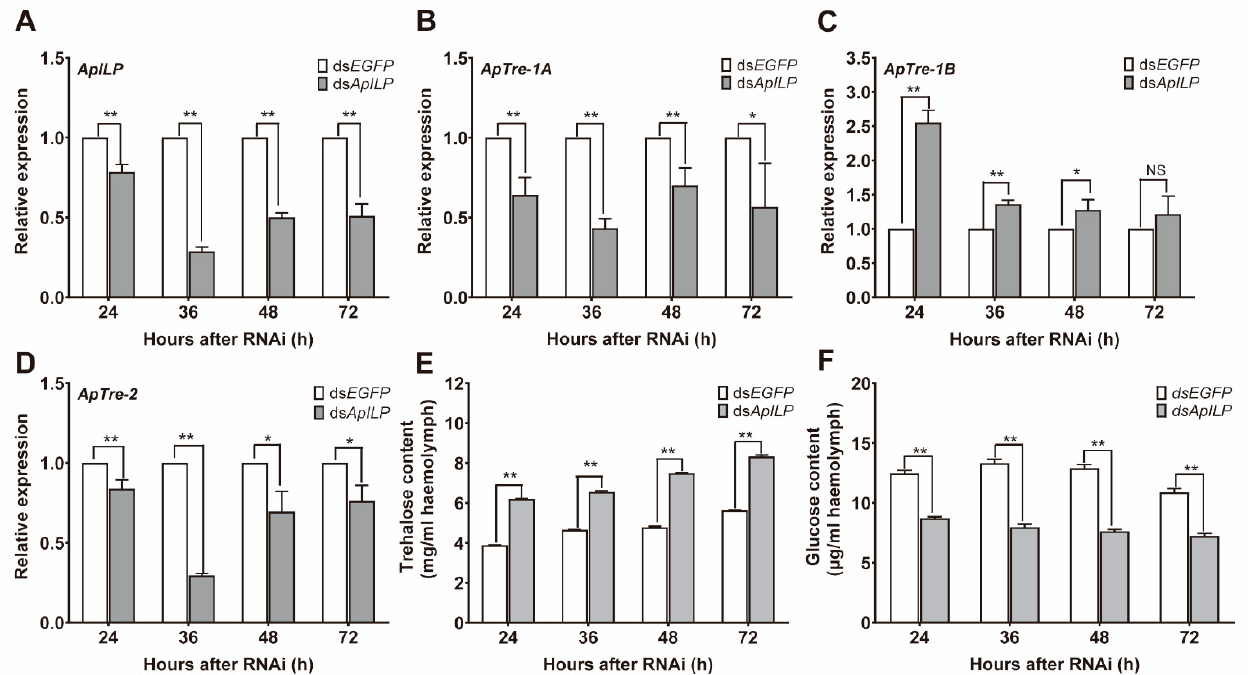
Figure 3. Effects of ApILP -specific RNA interference (RNAi) on trehalose metabolism in diapausing A. pernyi pupae during diapause termination. To effectively break diapause, diapausing A. pernyi pupae were placed under the long-day photoperiod conditions (L:D 17:7) for 17 days before receiving either ds ApILP or ds EGFP treatments. ( A – D ) Relative expression levels of ApILP , ApTre-1A , ApTre-1B , and ApTre-2 , respectively. ( E , F ) Changes in trehalose and glucose levels, respectively, in the haemolymph. mRNA levels were normalised to those of the reference genes actin and RP49 , and the group injected with ds EGFP served as controls. Data are means of three independent experiments, and error bars are SEs. Single asterisks ( p < 0.05) and double asterisks ( p < 0.01) represent significant differences between the ds EGFP and ds ApILP groups in the same time period.